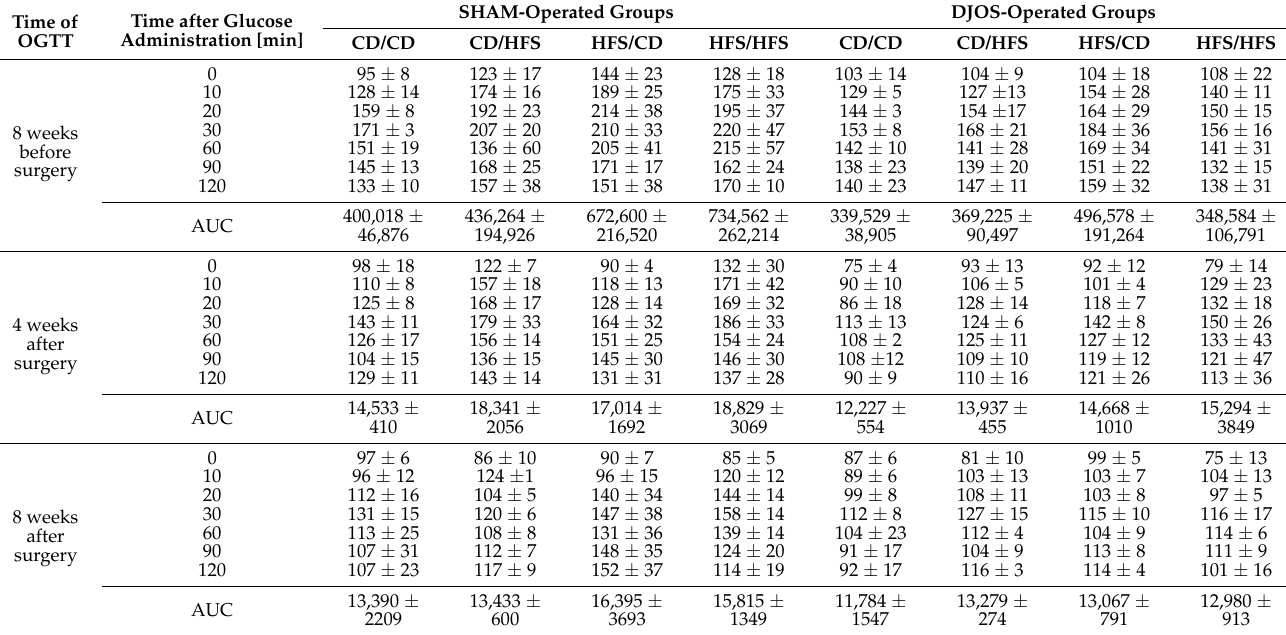
Table 1. Time profile of glucose concentration (mg/dl) and area under the curve (AUC) of the oral glucose tolerance test (OGTT) of Sprague–Dawley rats subjected to control (SHAM) and duodenojejunal omega switch (DJOS) surgery and different dietary regimes at 8 weeks before and 4 and 8 weeks after the surgery. The results are presented as mean ± standard deviation. Time after Glucose Time of Administration [min] OGTT